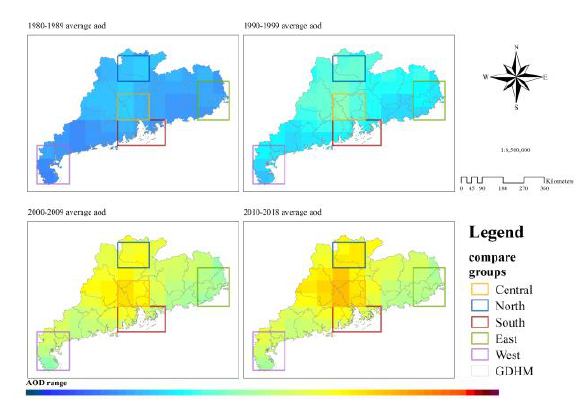
border line, the maps in Figure 6 also present that west part of Guangzhou, most part of Foshan, central south of Shaoguan and central south of Qingyuan are always the areas with the higher AOD yearly average than the in these four time groups. AOD averages of the west side of Guangzhou divided by the grid line are always higher than the values of the east side of Guangzhou in each decadal